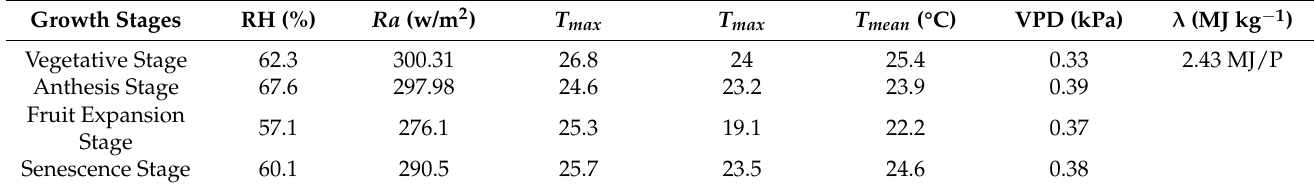
Table 4. Climatological information collected at various phases of crop development.